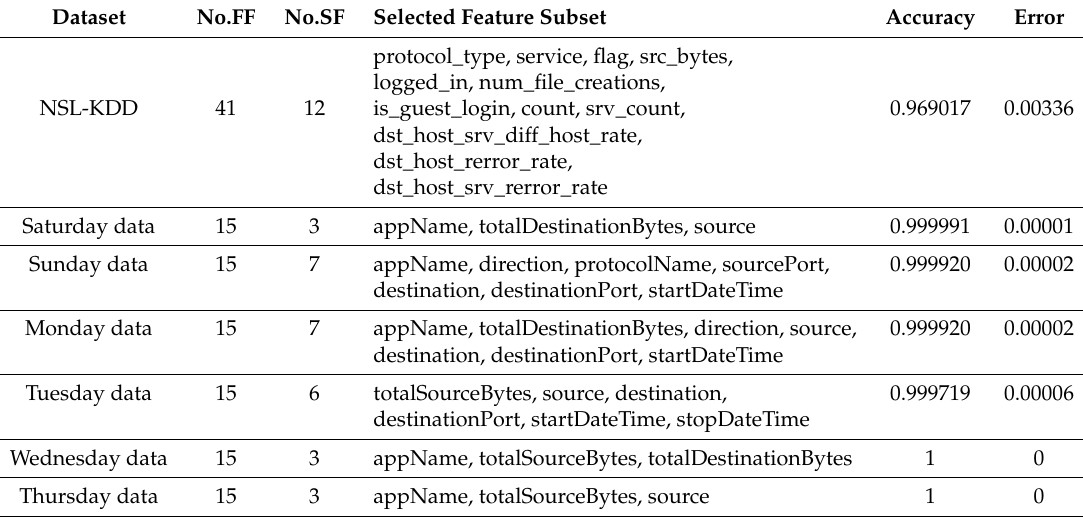
Table 2. The selected feature subset by SFSDT algorithm on two IDS